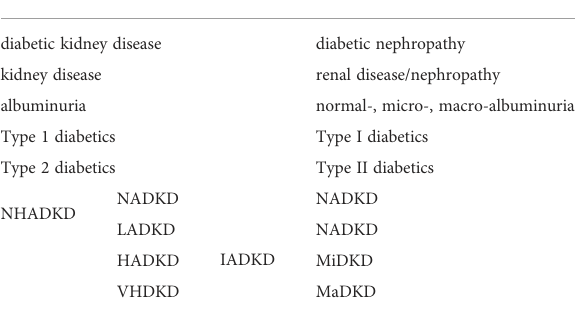
TABLE 1 Change of